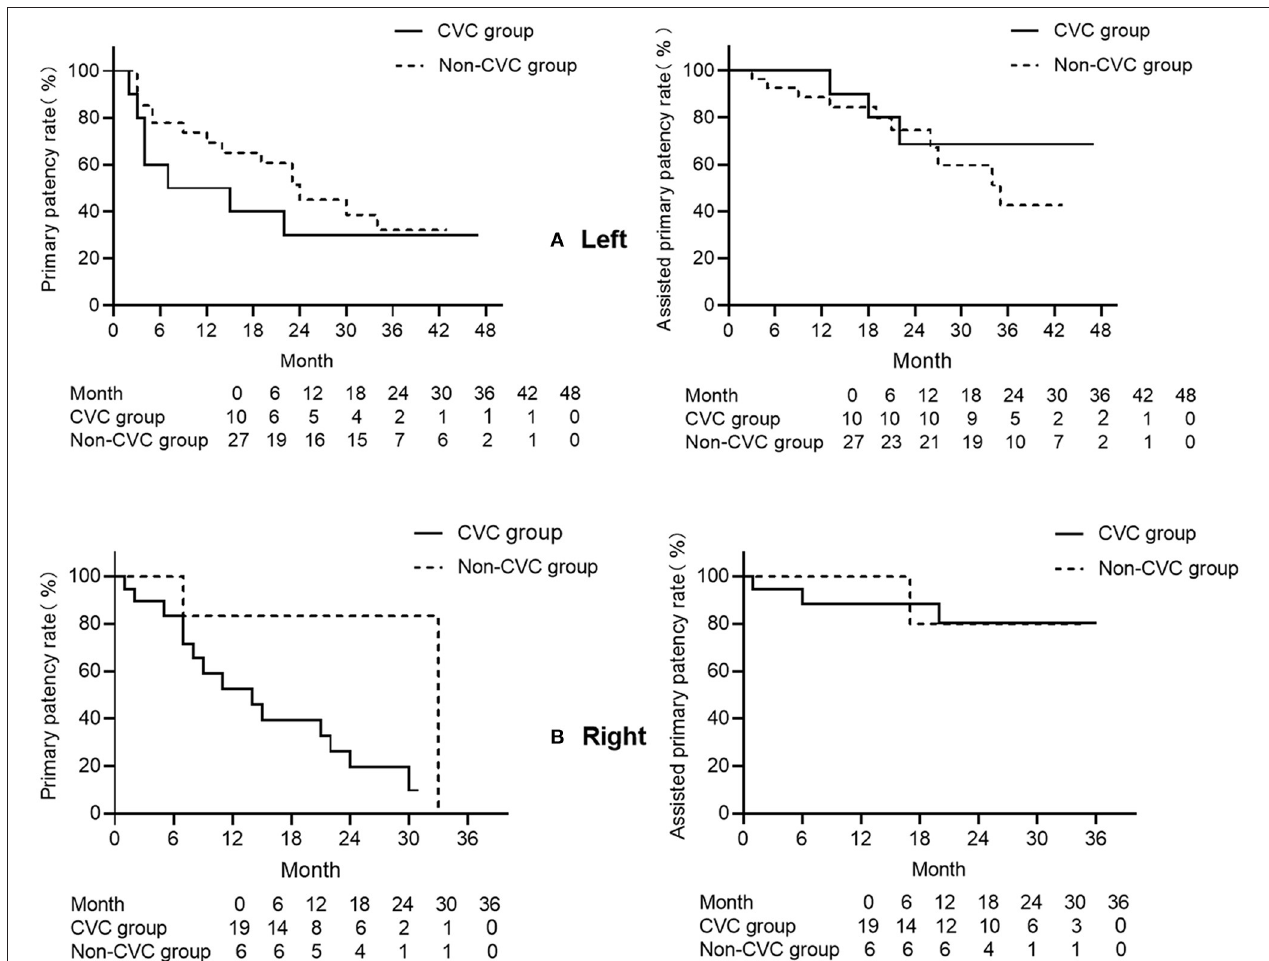
FIGURE 2 | (A) The Kaplan–Meier curves of the primary patency (left) and assisted primary patency (right) for left-side central venous lesions with (CVC group) or without (non-CVC group) previous left central venous catheter placement history. The CVC group is depicted with solid lines and the non-CVC group with the dotted line. The primary patency in the CVC group tends to be lower after 7 months, and this tendency lasted to 30 months ( p = 0.269). The assisted primary patency in the non-CVC group tends to be lower after 30 months ( p = 0.725). (B) The Kaplan–Meier curves of the primary patency (left) and assisted primary patency (right) for right-side central venous lesions with (CVC group) or without (non-CVC group) previous right-side central venous catheter placement history. The CVC group is depicted with solid lines and the non-CVC group with the dotted line. The primary patency in the CVC group tends to be lower after 7 months ( p = 0.900), and no significant difference is revealed between the two groups in assisted primary patency ( p =